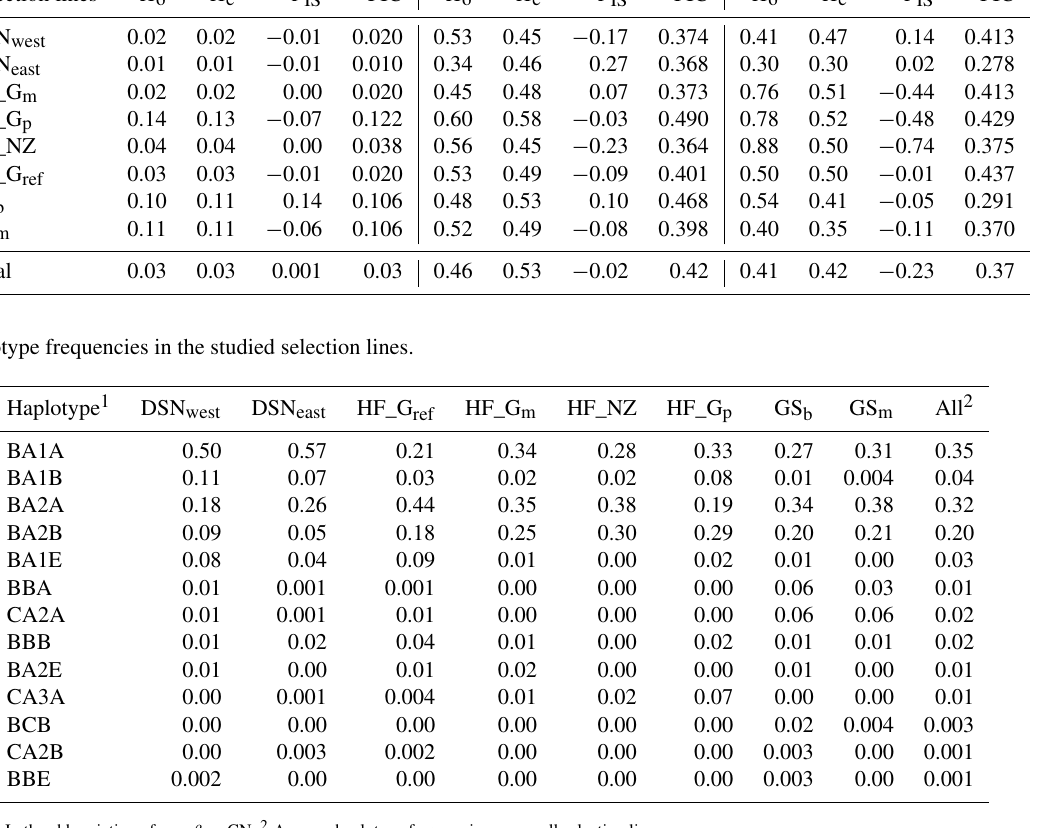
tions, whereas the second linear discriminant distinguished between the Simmental subpopulations from all other selec- tion